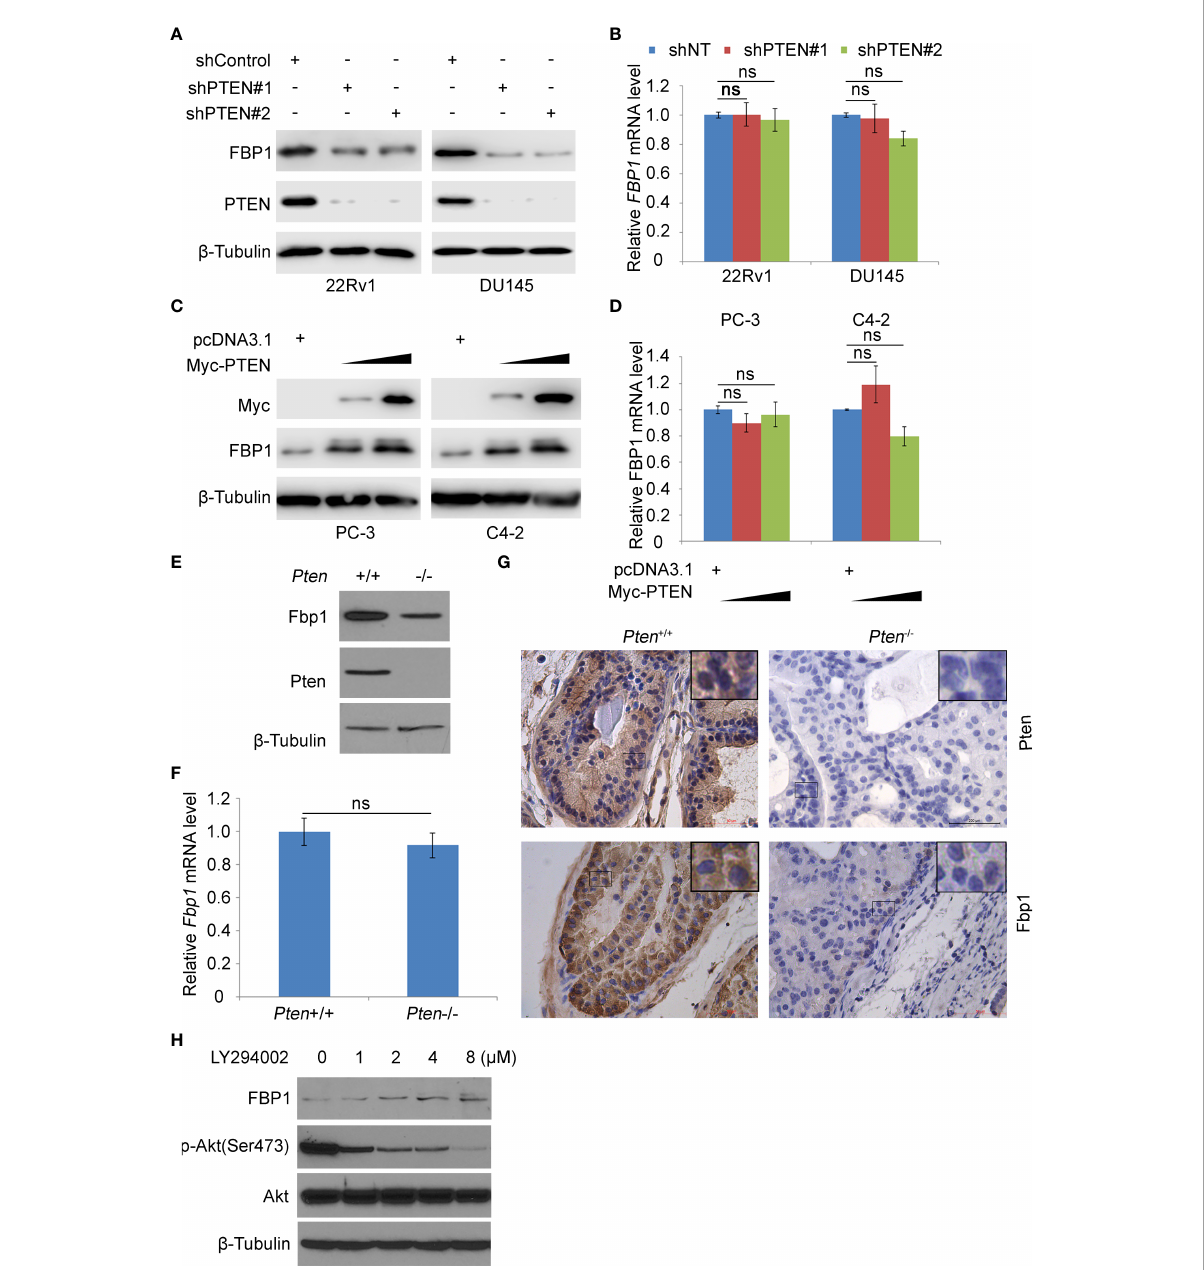
FIGURE 1 PTEN positively regulates FBP1 in human PCa cell lines and murine prostate tumors. (A, B) WB (A) and RT-PCR (B) were performed in 22Rv1 and DU145 cells infected with lentivirus expressing control or PTEN shRNAs for 48 h. b -Tubulin was used as a WB loading control. All quantitative data are shown as Mean ± SD (n=3). Student ’ s t test. n.s., not signi fi cant. (C, D) WB (C) and RT-PCR (D) were performed in PC-3 and C4-2 cells transfected with pcDNA3.1 or FBP1 expression plasmid for 24 h. All quantitative data are shown as Mean ± SD (n=3). Student ’ s t test. n.s., not signi fi cant. (E, F) WB (E) and RT-PCR (F) were performed in MEFs generated from Pten p/p conditional mice infected with or without infected with lentivirus expressing CMV-driven Cre. All quantitative data are shown as Mean ± SD (n=3). Student ’ s t test. n.s., not signi fi cant. (G) Photos of IHC of Fbp1 and Pten protein in the FFPE prostate tissues of Cre-negative mice (left column) and prostate tumors in Cre-positive mice (right column) at 5 months of age. (H) LNCaP cells were treated with LY294002 at the indicated concentrations for 24 h and then analyzed by